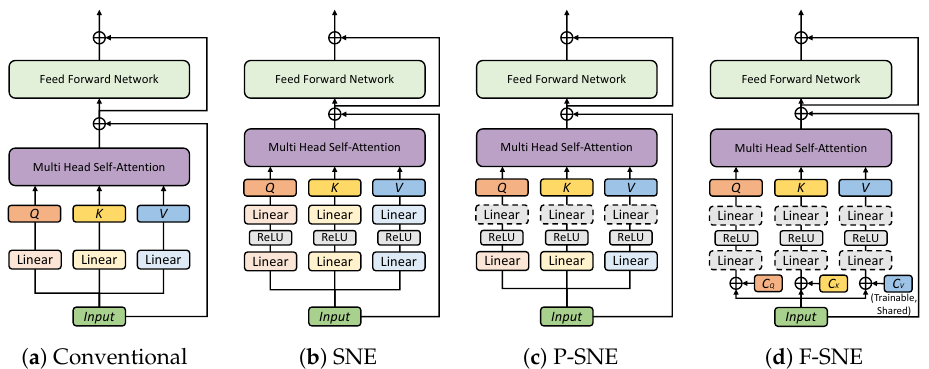
Figure 1. Four types of Q , K , and V embedding methods are shown. ( a ) The figure depicts conven- tional embedding used in the standard transformer encoder. ( b ) Separate non-linear embedding utilizes a two-layer embedding, including non-linearity functions (e.g., ReLU). ( c ) Partially shared non-linear embedding includes a weight-sharing linear layer. The weight-sharing layer is depicted as the gray dotted line block, and it follows after the separated linear layer and ReLU. ( d ) Fully shared non-linear embedding includes two weight-sharing linear layers, also depicted as a gray dotted line, with ReLU. In this case, trainable codes of Q , K , V ( C q , C k , and C v ) are concatenated to the input